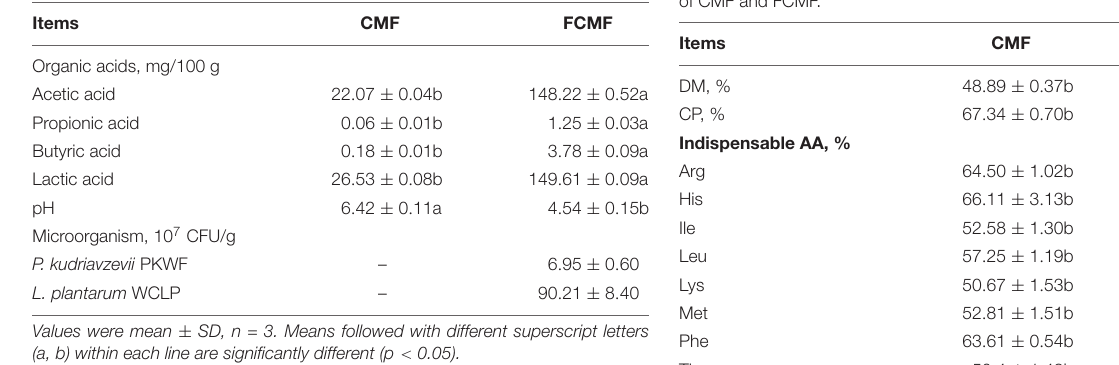
TABLE 3 | Microorganism and microbial metabolites of CMF and FCMF. Items CMF Organic acids, mg/100 g Acetic acid Propionic acid